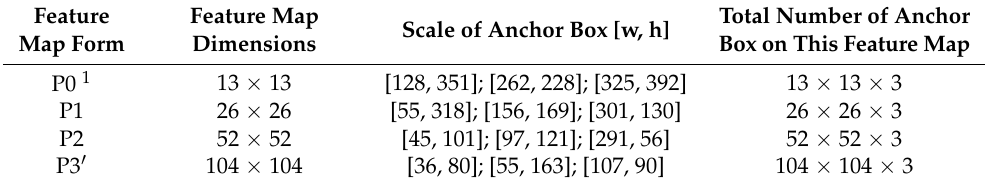
Table 2. Parameters of three anchor